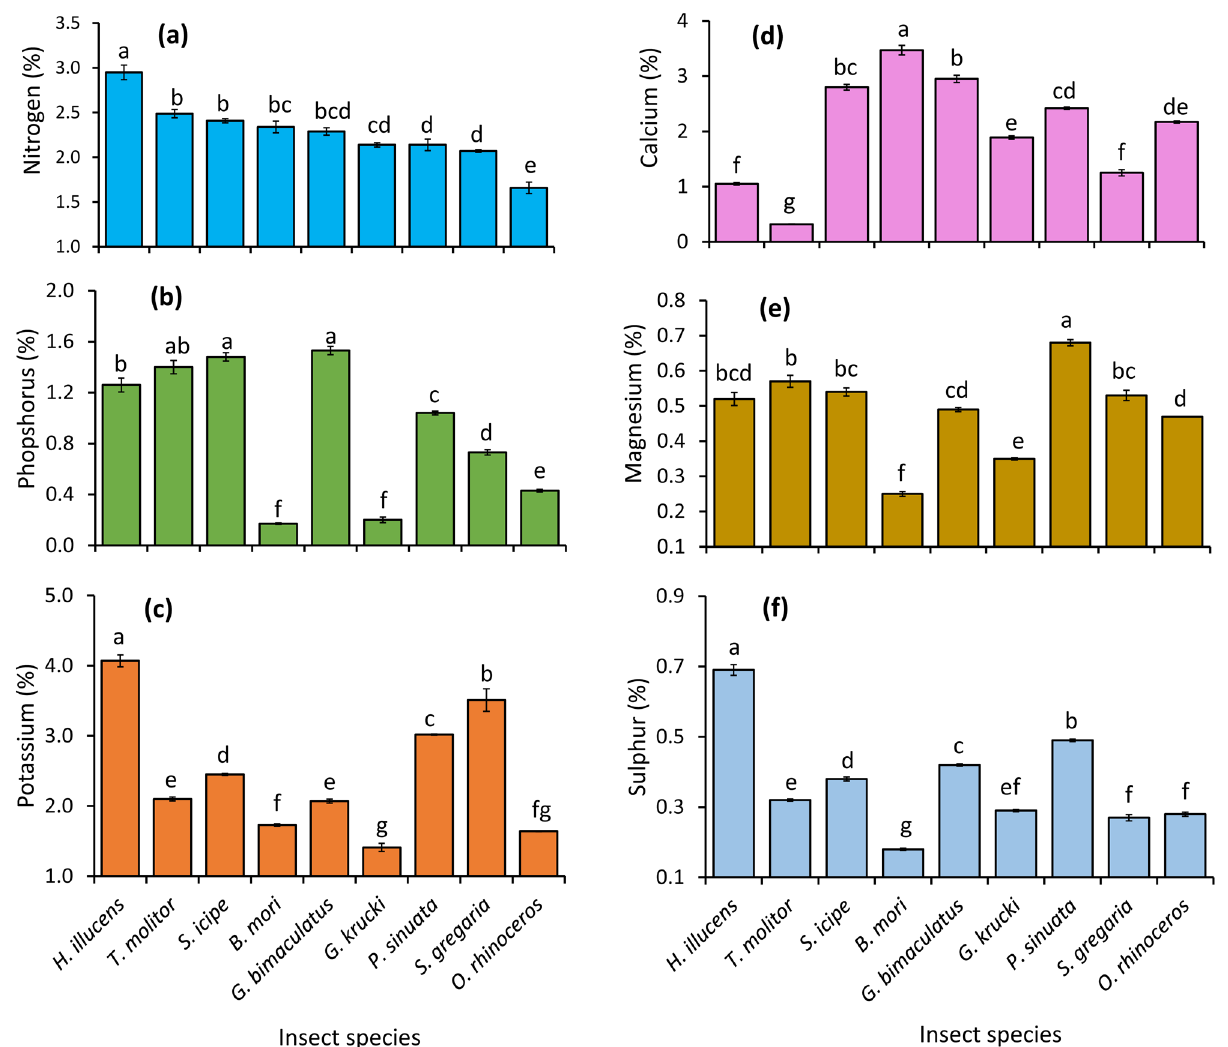
Figure 1. Total concentrations of nitrogen ( a ), phosphorus ( b ), potassium ( c ), calcium ( d ), magnesium ( e ) and sulphur ( f ) in frass fertilizer generated by different edible insects. Per panel, means (± standard error) followed by the same letters are not significantly different at p ≤ 0.05, n =